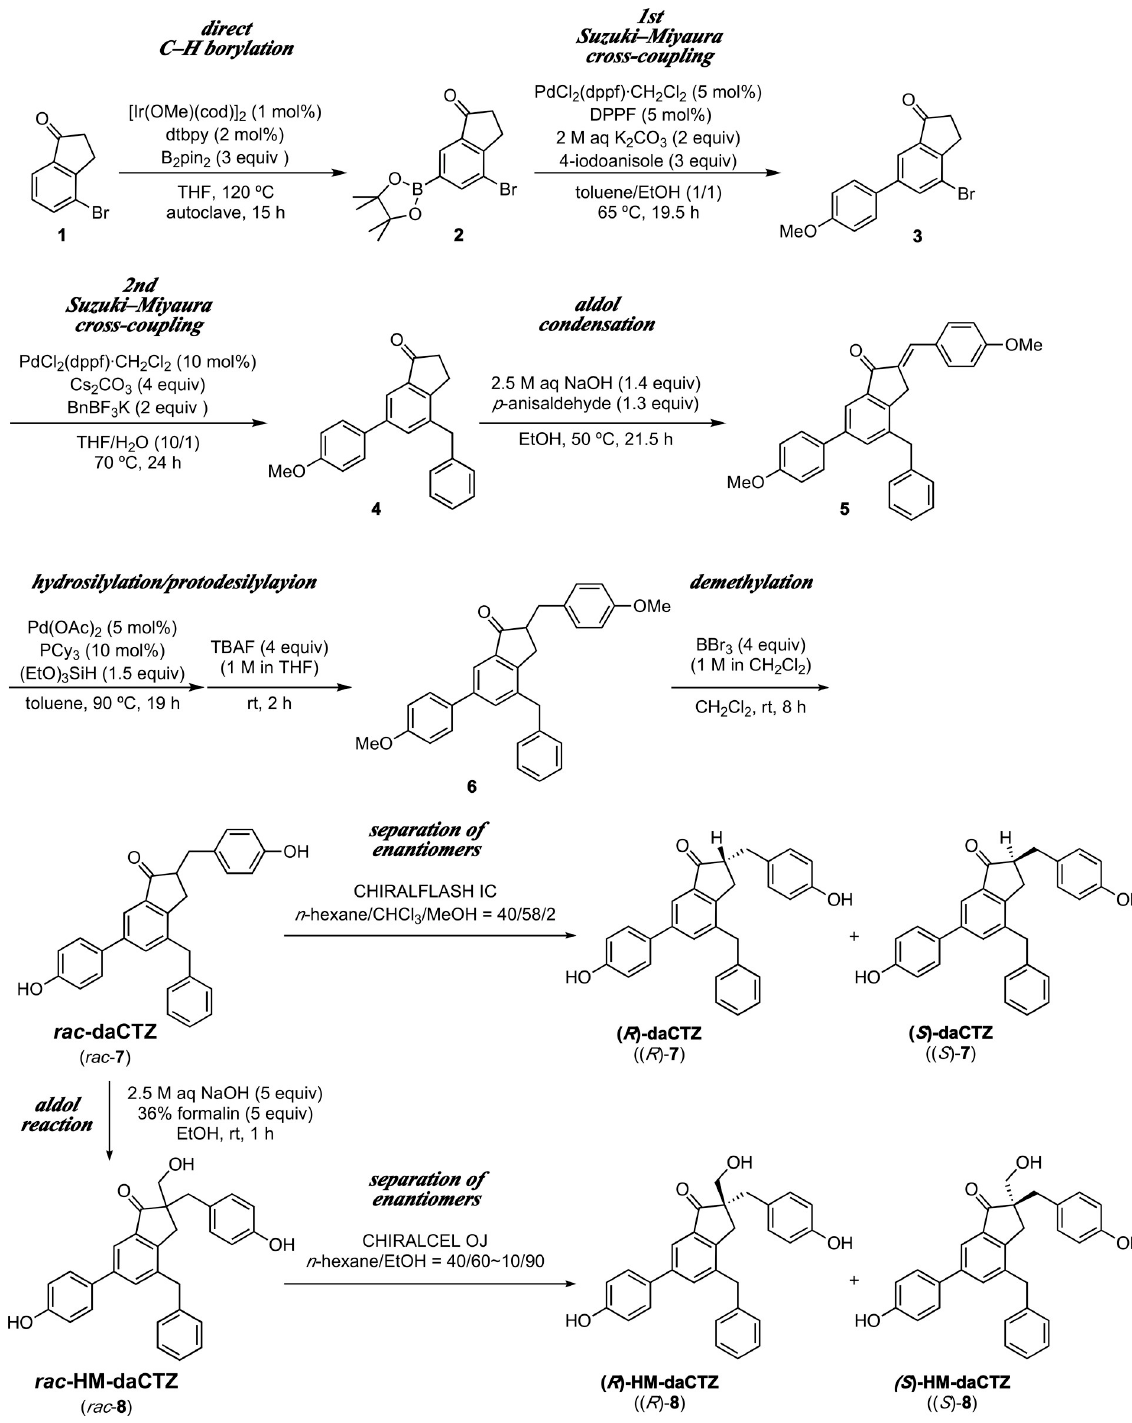
Fig 4. Synthetic route of the racemic deaza-CTZ (daCTZ) compounds, ( R )- and ( S )-daCTZ, and hydroxymethyl-deaza-CTZ (HM- daCTZ), ( R )-2- and ( S )-2-HM-daCTZ, and each enantiomer separation.